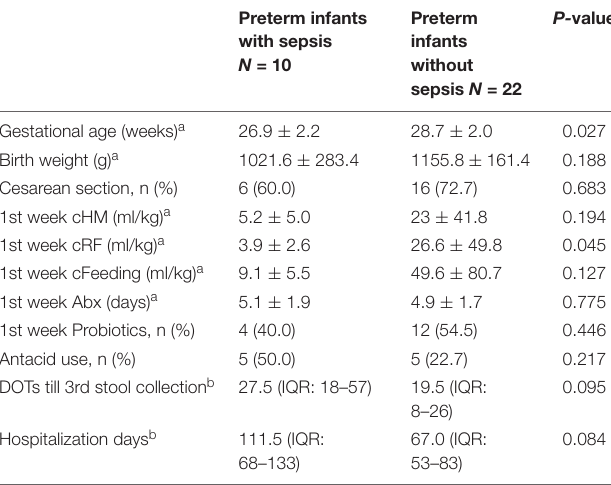
TABLE 1 | Clinical information of very-low-birth-weight (VLBW) preterm infants with or without neonatal sepsis.